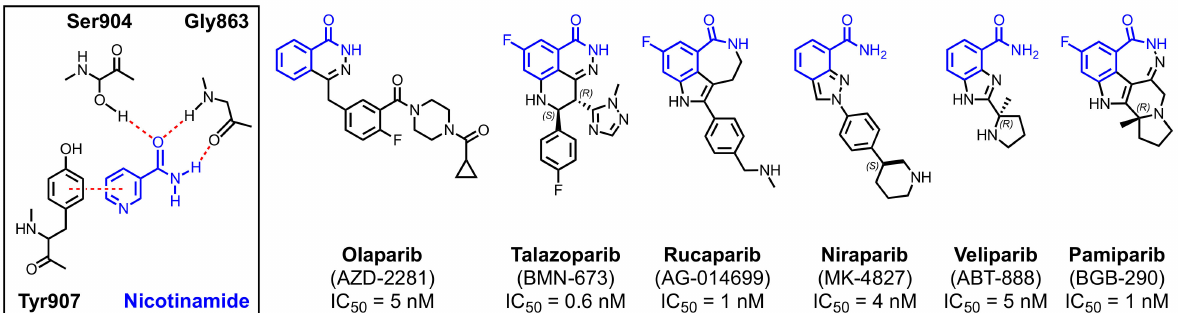
Figure 3. FDA-Approved and Clinically Advanced PARP Inhibitors. The panel inset depicts nicotinamide (blue) and its highly conserved interactions with PARP1-4, including hydrogen bonds with serine 904 and glycine 863 and a promi- nent π -stacking interaction with tyrosine 907 (using PARP1 amino acid numbers). The FDA-approved PARPi olaparib, talazoparib, rucaparib, and niraparib as well as the clinically advanced inhibitors veliparib and pamiparib are compared. The nicotinamide motif of each inhibitor is depicted in blue. The reported IC 50 values for inhibition of purified PARP1 enzymatic activity are also